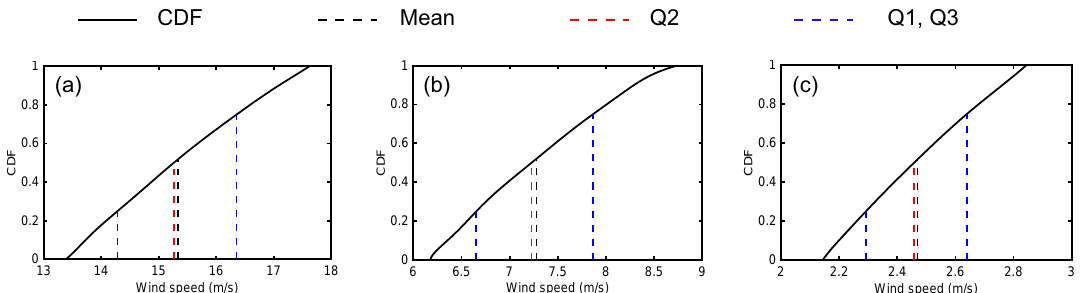
Figure 7. The cumulative distribution functions (CDFs) of the wind speed at turbine No.1 site for case1 ( a ), case2 ( b ) and case3 ( c ). Mean value location is indicated by the black dotted line, and Q2 location (CDF value equals to 50%) by red dotted line. The left-most dotted blue line indicates the Q1 location (CDF value equals to 25%), while the right-most dotted blue line indicates the Q3 location (CDF value equals to 75%),